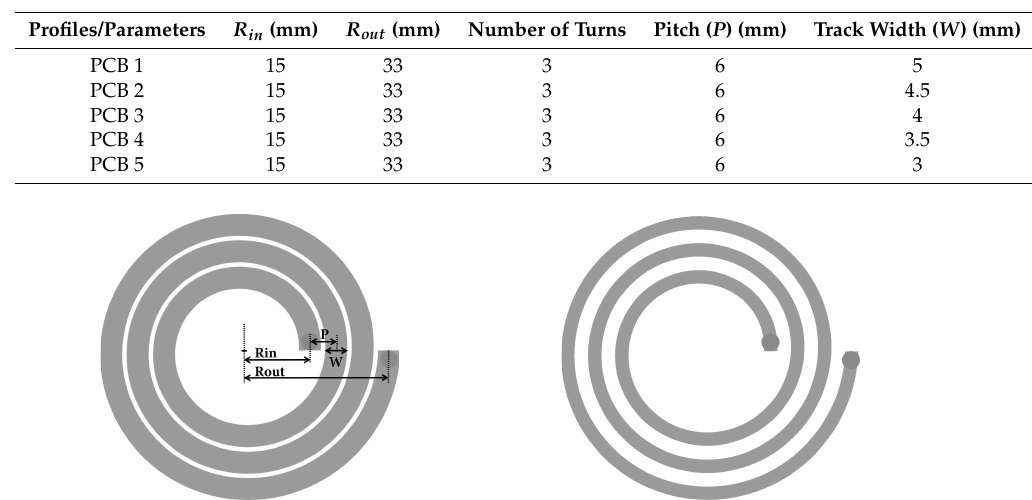
Table 2. Dimensional parameters of three-turn PCB windings.